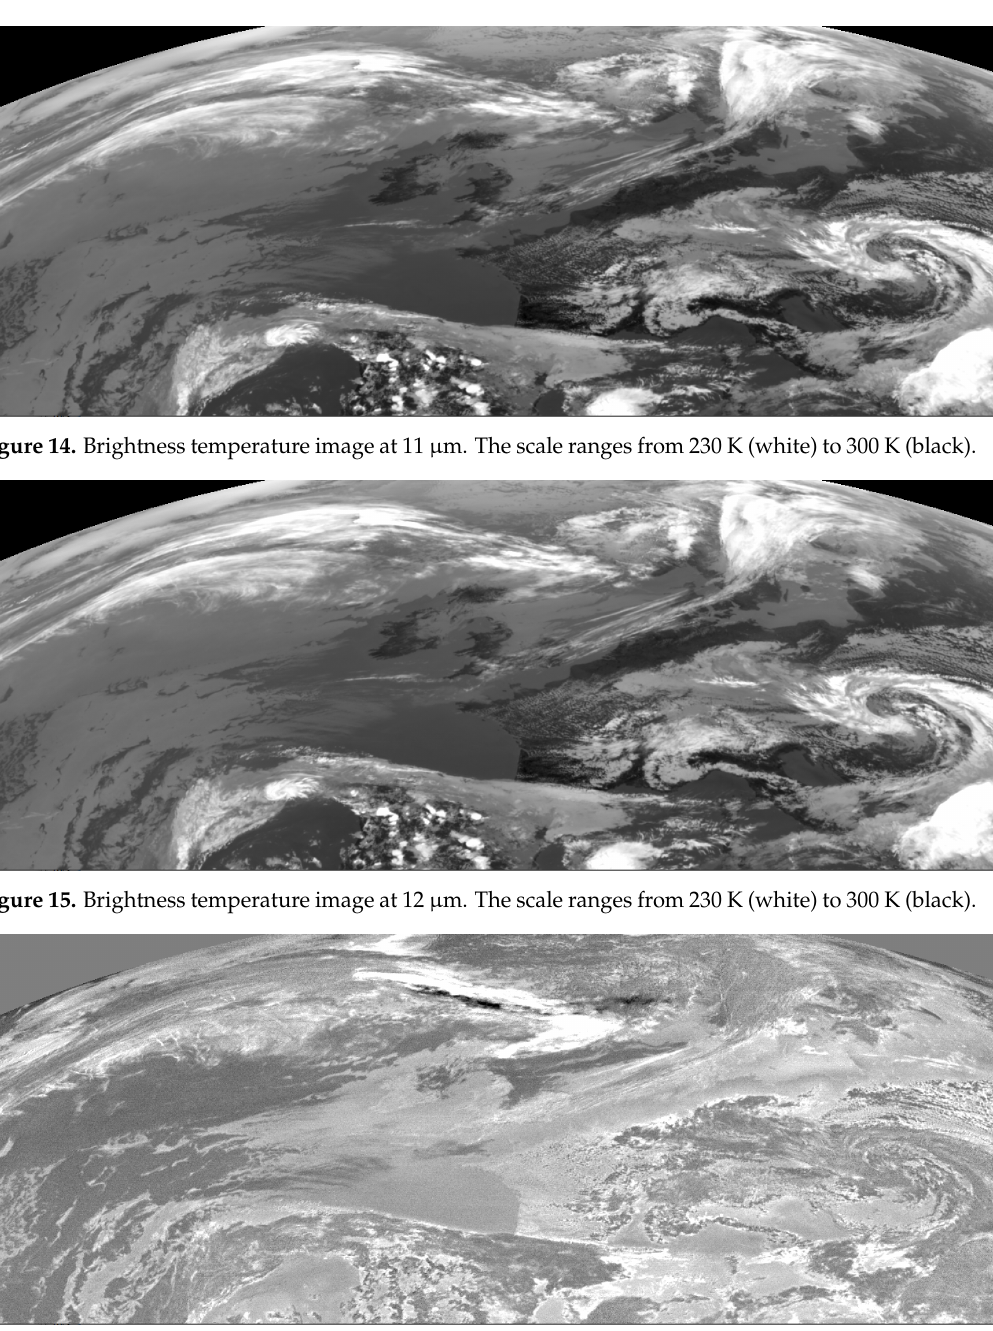
Figure 16. Brightness temperature difference image at 11–12 µ m. The scale ranges from − 3 K (black) to 3 K (white). Ash clouds appear black in these